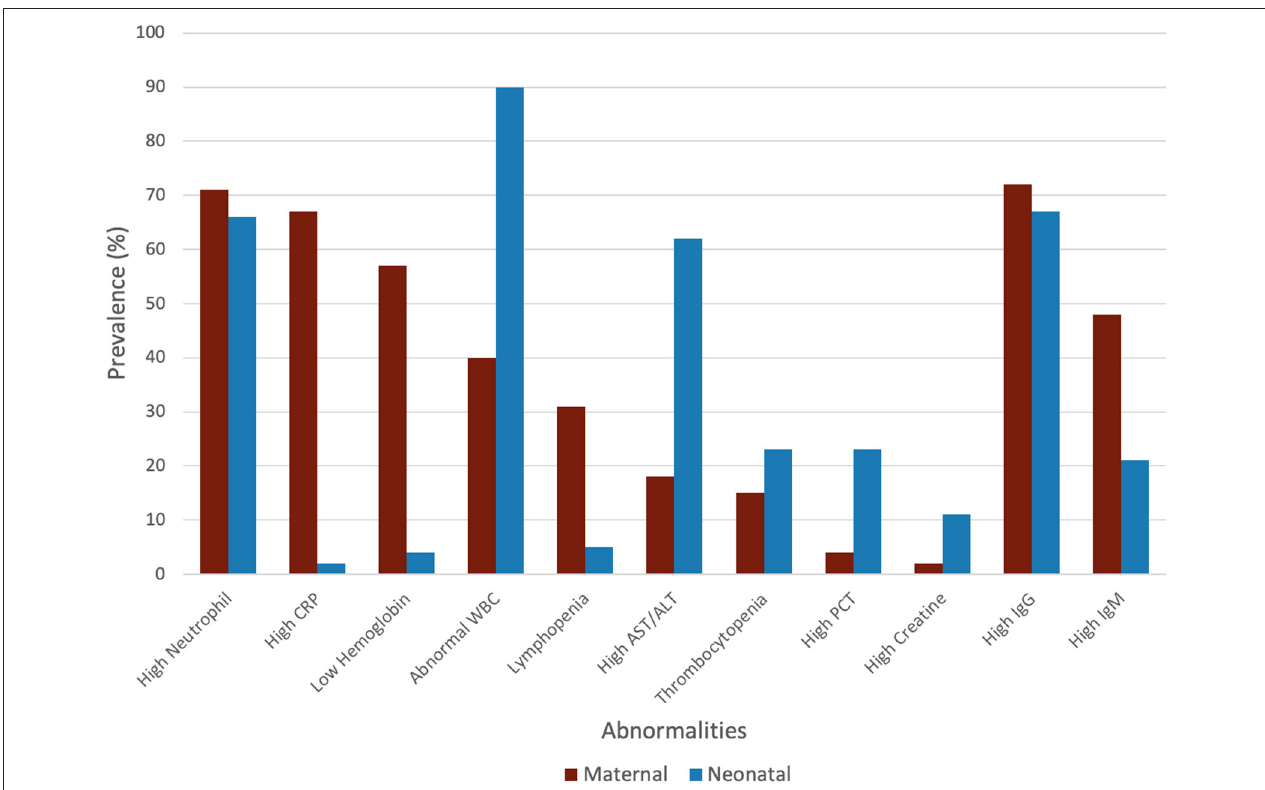
FIGURE 2 | Prevalence of maternal and neonatal